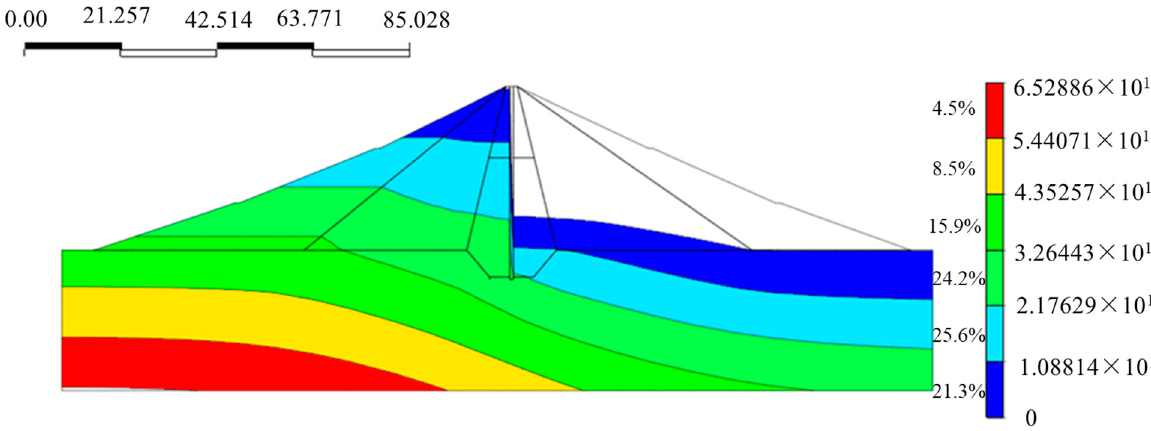
Figure 11. Seepage pressure contour map of the checking flood level by the proposed method.